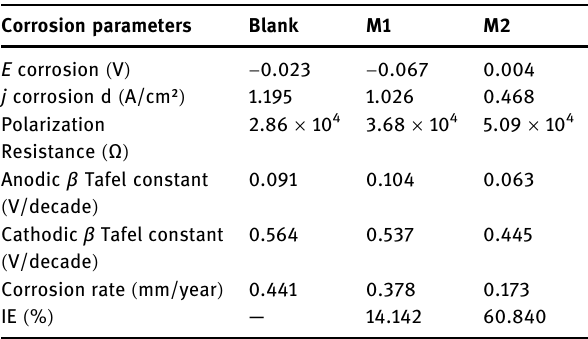
Table 1: Results of Tafel slope analysis of the polarization plots at 298